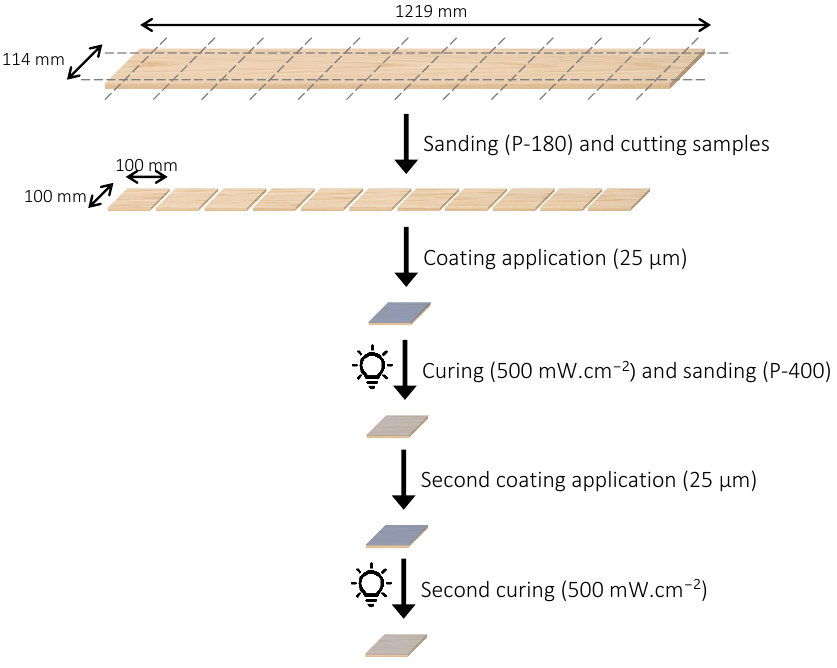
Figure 1. Wood sample preparation for the cone calorimeter